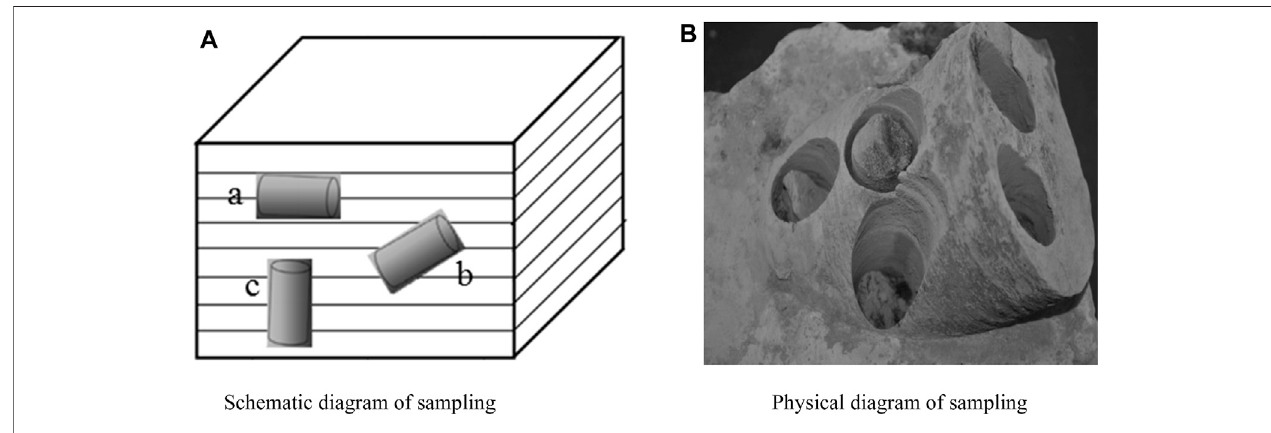
FIGURE 1 | Sampling diagram at different bedding angles.